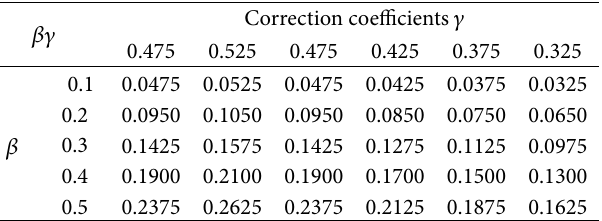
Table 5: The corrected